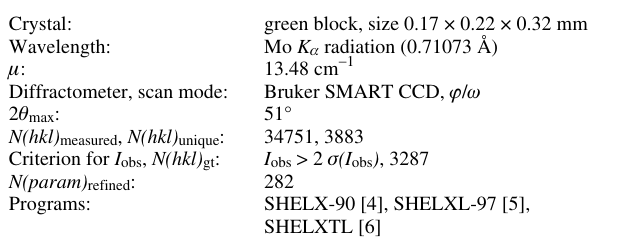
Table 1. Data collection and